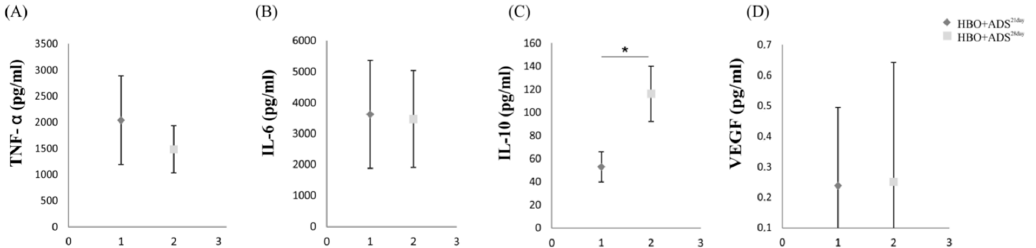
Figure 7. Changes in cytokine serum levels measured as ( A ) TNF- α , ( B ) IL-6, ( C ) IL-10 and ( D ) VEGF between HBO+ADS 21day and HBO+ADS 28day groups. * p < 0.05 indicates statistical significant differences between